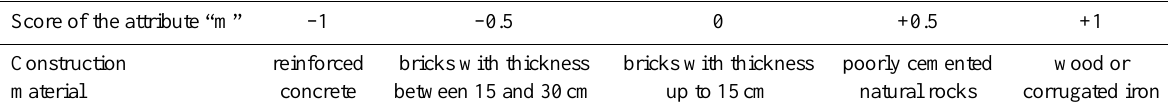
Table 2. Scores given to the attribute “m” (building material). These scores have been modified with respect to the original PTVA-3 Model in order to fit with the typical construction standards used at the Aeolian Islands.